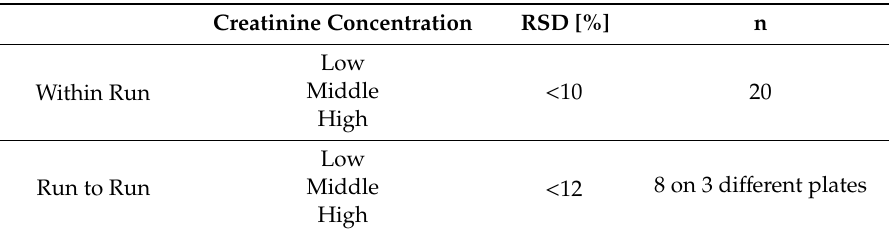
Table 3. Intra-assay and inter-assay